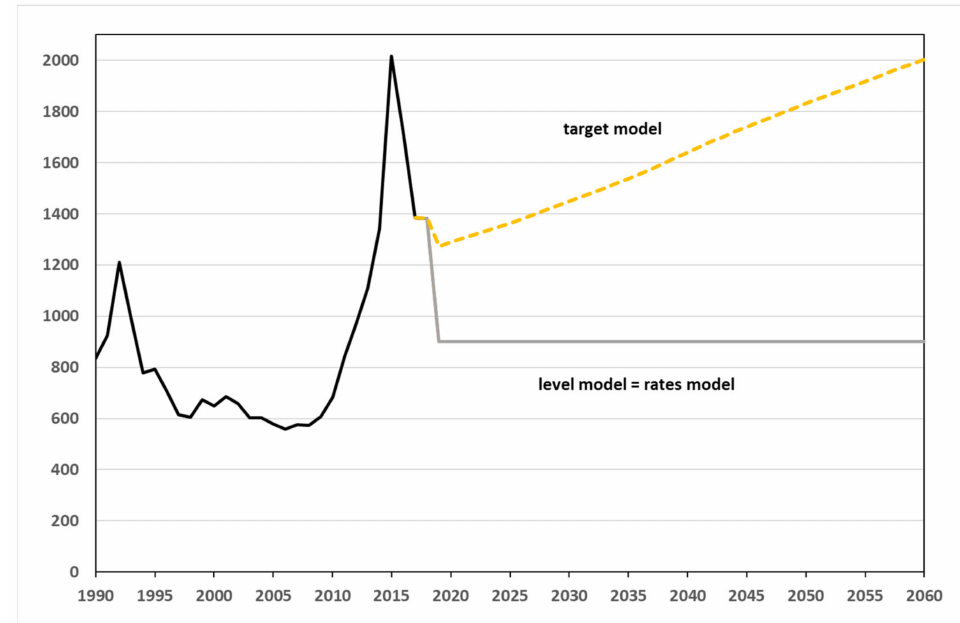
Figure 5. Immigration of the non-German population until 2060 (in k)—simulation results from 2019 onwards. (Sources: [57]; own computation and design.)